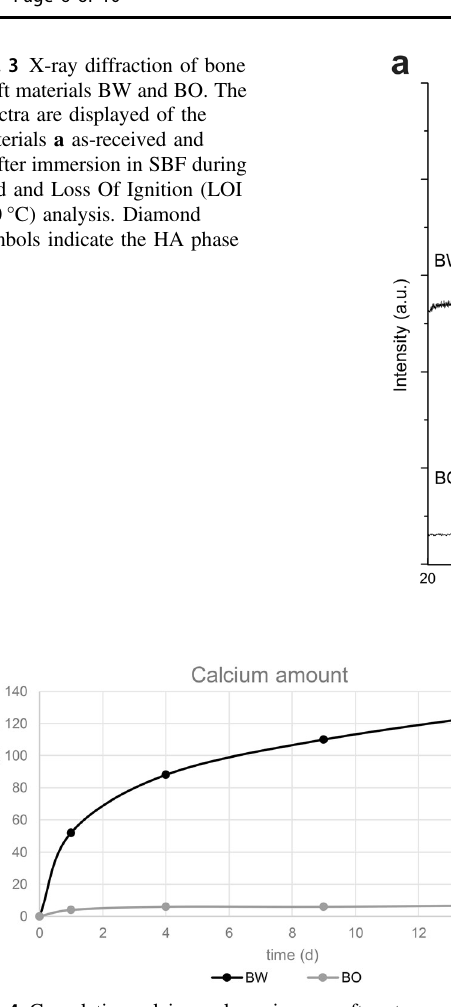
Fig. 4 Cumulative calcium release in ppm after storage of bone graft materials BW and BO in distilled